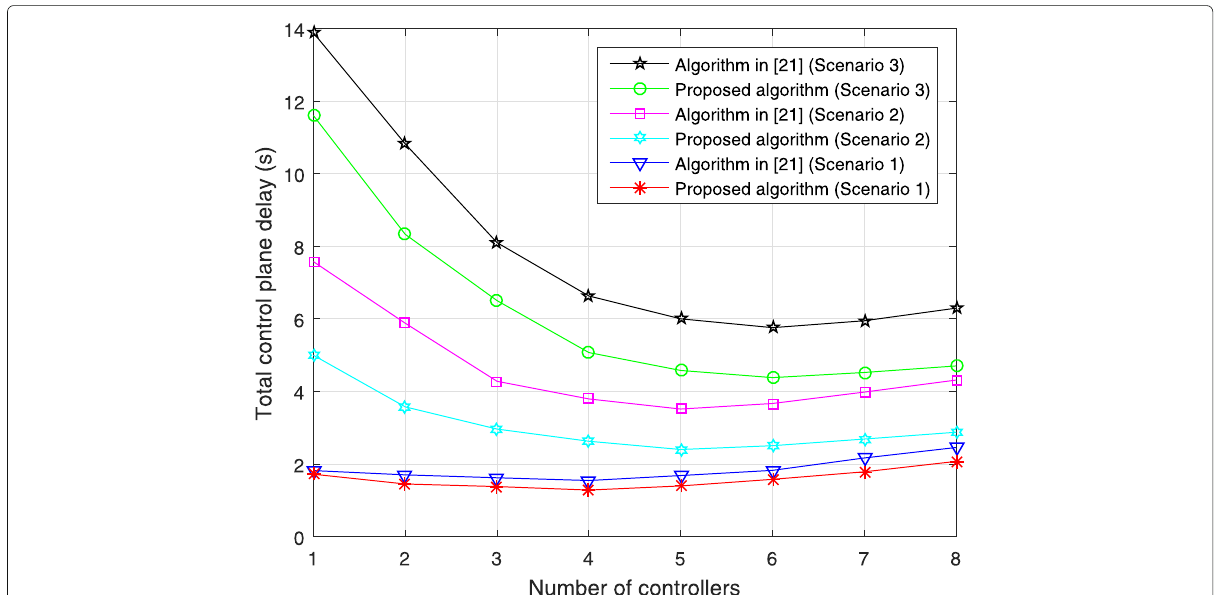
Fig. 3 Control plane delay versus the number of controllers (different scenarios). The control plane delay versus the number of controllers for different scenarios